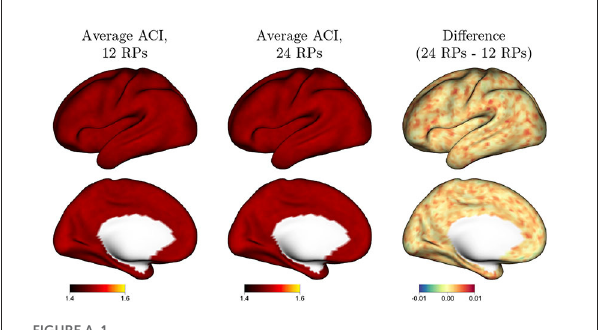
FIGUREA.1 Effect of including additional motion covariates on autocorrelation, when effective prewhitening is performed. For prewhitening, we use an AR(6) model with local regularization of AR model coefficients, which we observe to be highly effective at reducing autocorrelation. The first two columns show the average autocorrelation index (ACI) across all subjects, sessions and tasks when 12 realignment parameters (RPs) or 24 RPs are included in each GLM. The last column shows the difference (24 RPs–12 RPs). The mostly warm colors indicate that using additional RPs results in very slightly worse autocorrelation when effective prewhitening is performed.